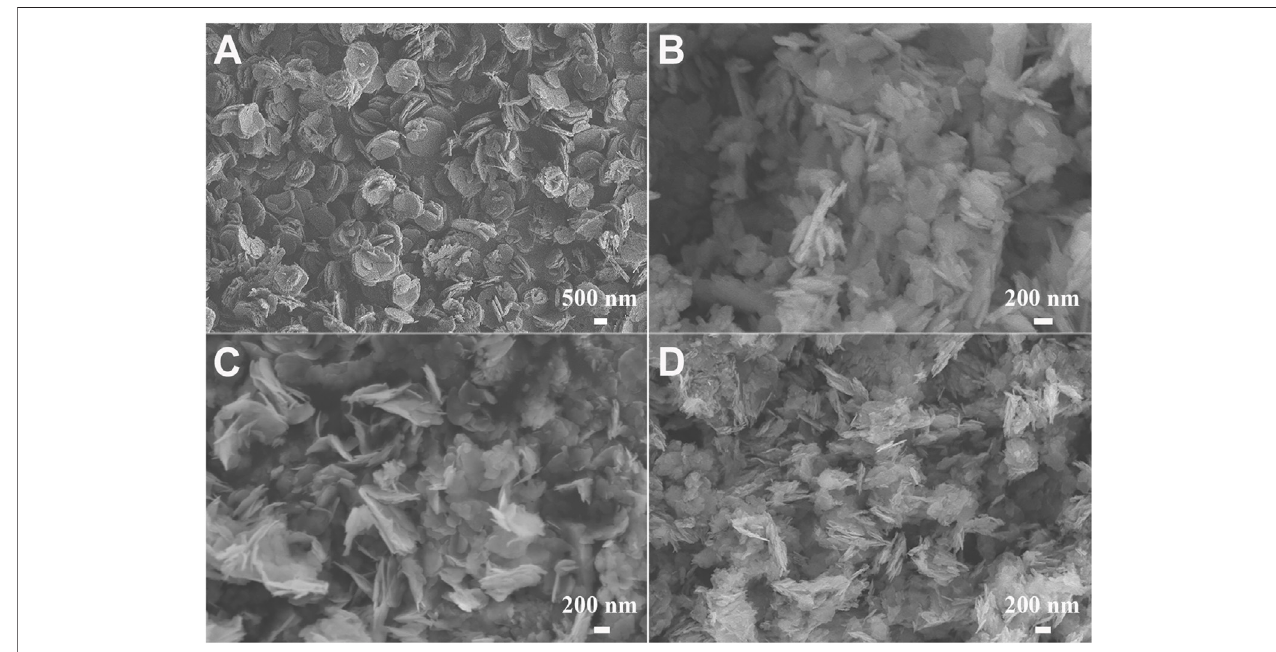
FIGURE 2 | SEM images of (A) CoAl-LDH, (B) CuCoAl-LDH, (C) CuCoNiAl-LDH, and (D) CuCoNi A l-MMO.